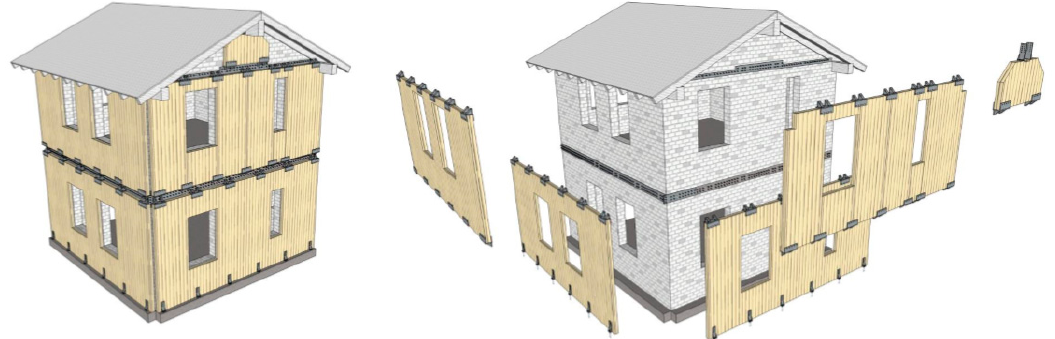
Figure 5. Retrofitting with CLT proposed by Sustersic [95].